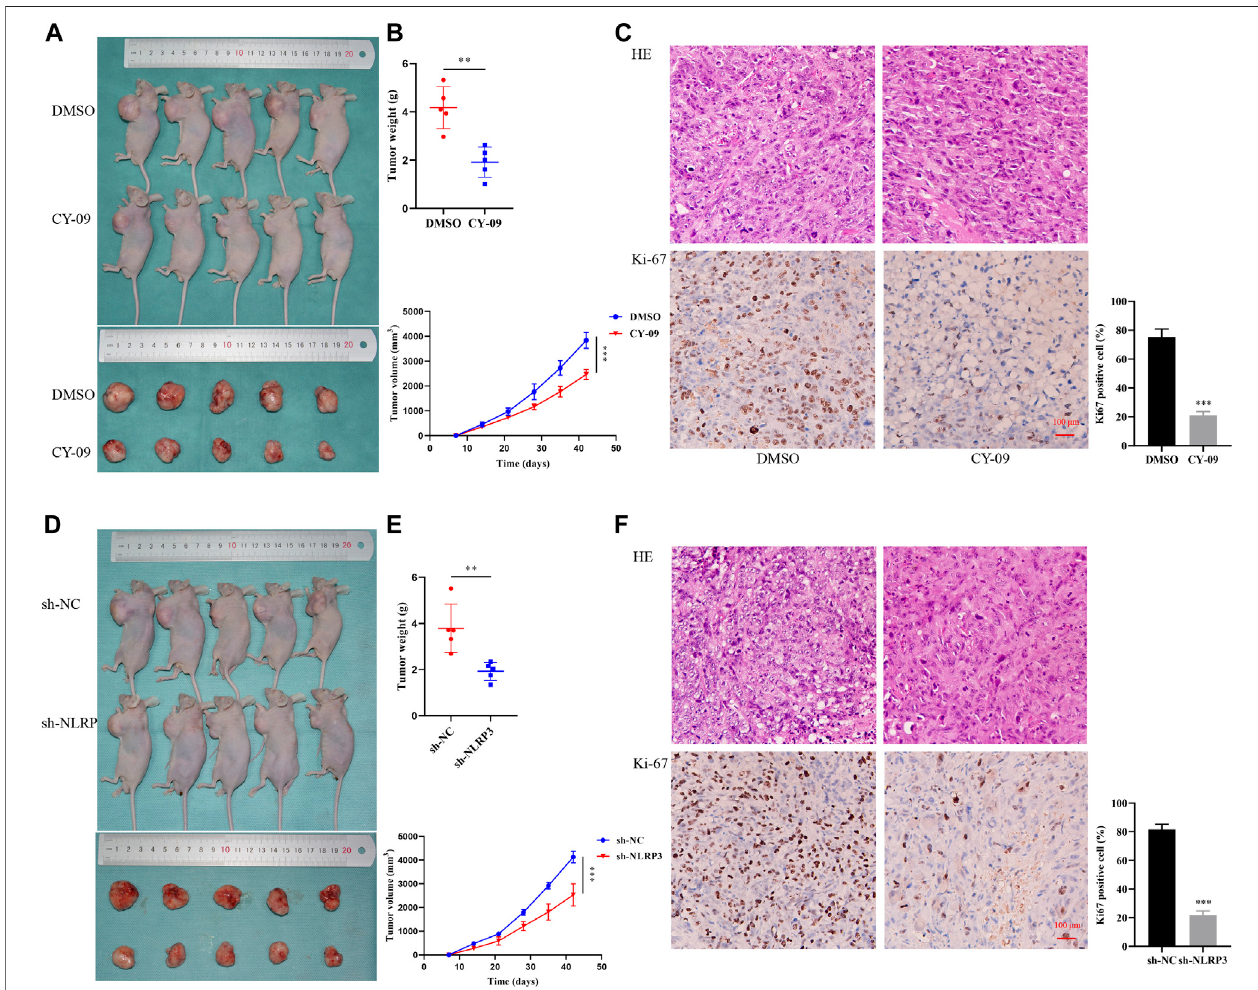
FIGURE7| EffectofNLRP3ontumorformationinosteosarcoma invivo (A,B) ImagesofthexenograftedtumoraswellasthetumorweightandvolumeafterCY-09 treatment (C) H&EstainingandimmunohistochemicalstainingofKi-67oftheosteosarcomatissuesaftertreatmentwithCY-09(D,E)Imagesofthexenograftedtumoras well as the tumor weight and volume after NLRP3 lentivirus infection (F) H&E staining, immunohistochemical and statistic staining of Ki-67 of the osteosarcoma tissues after NLRP3 lentivirus infection.